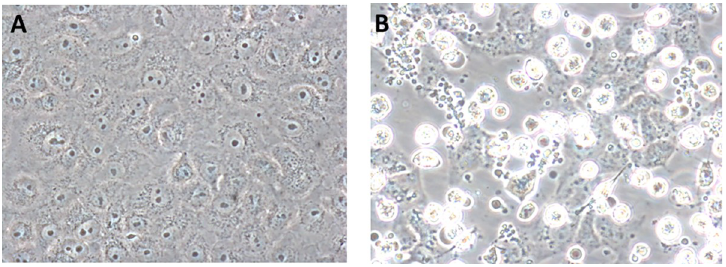
Fig 1. MELV isolation in Vero E6 cells. (A) Mock-infected Vero E6 cells. (B) Vero E6 cells 13 days post-inoculation with plasma from patient A. Apoptotic bodies and dead cells that have detached from the growth surface are evident. Original magnification 400X.